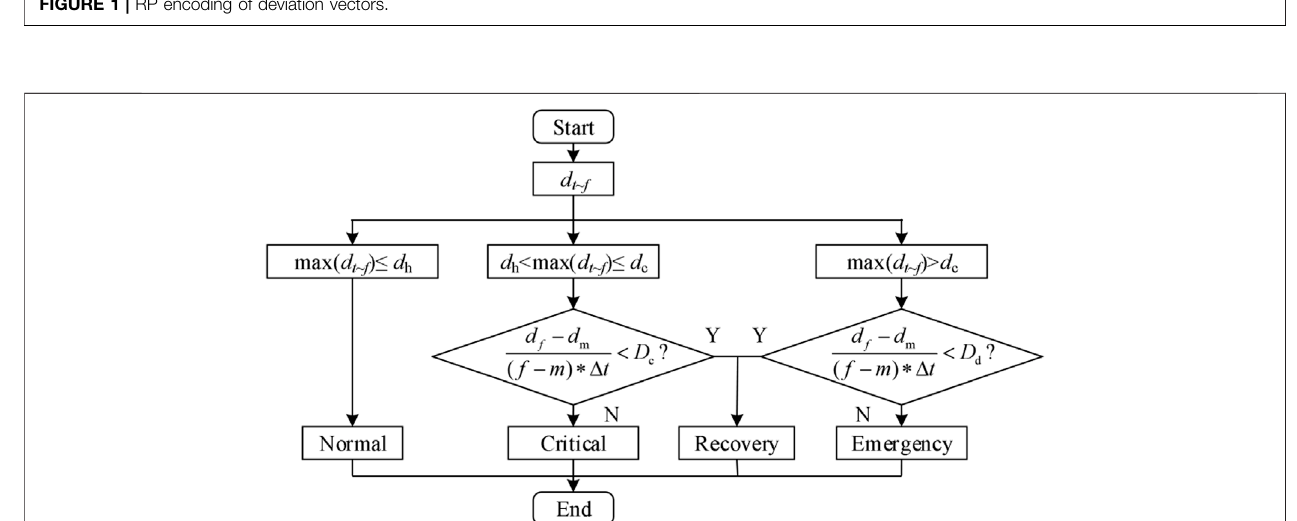
FIGURE 2 | Classi fi cation of operation